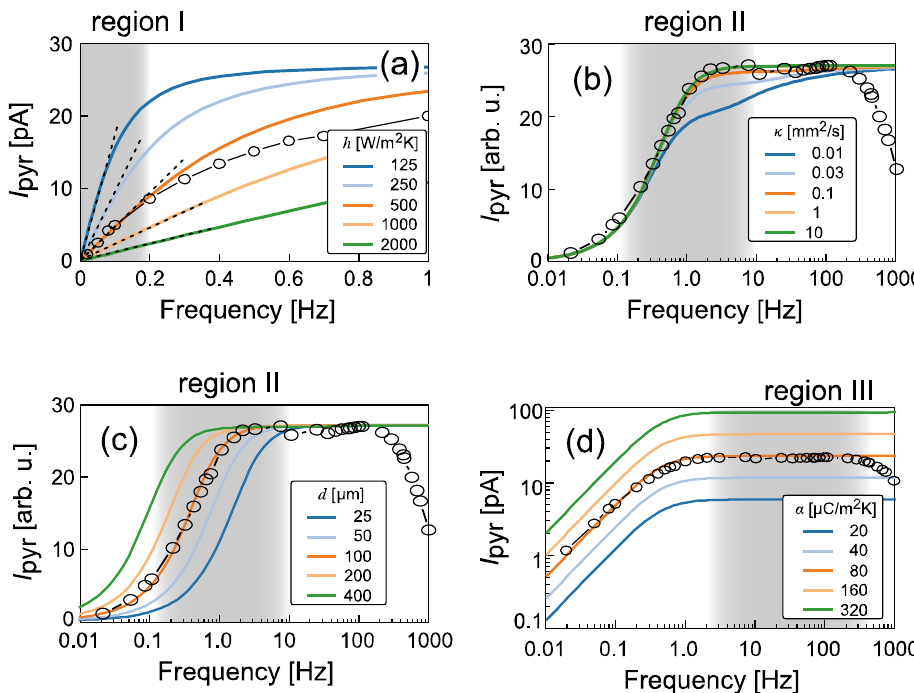
Figure 4. Comparisons between the observed pyroelectricity of the LiNbO 3 sample and the results of the single-layer model calculation plotted as a function of the temperature-modulation frequency. Four panels ( a – d ) show the dependence on h , κ , d , and α , respectively. Light intensity irradiated to the sample i 0 was 1.6 mW/mm 2 , estimated from the difference of light entering and exiting the cryostat. Physical quantities for LiNbO 3 other than the parameter selected as the variable in each plot are listed in Table 1.